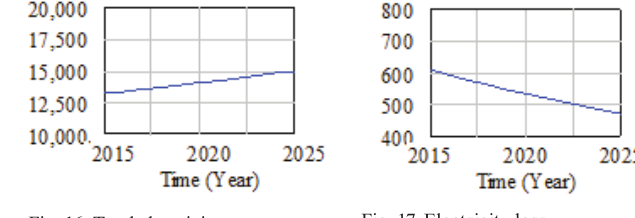
Fig. 16. Total electricity consumption.